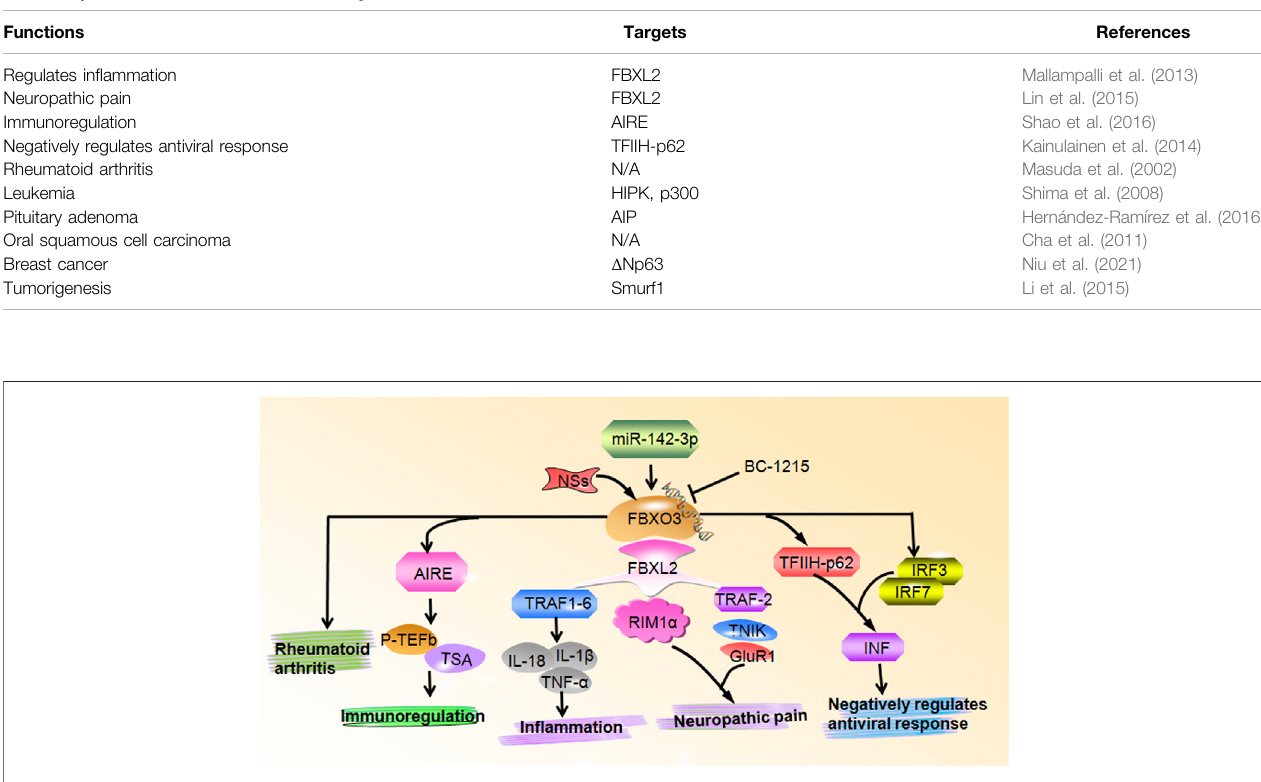
TABLE 1 | The roles of FBXO3 in various biological functions.